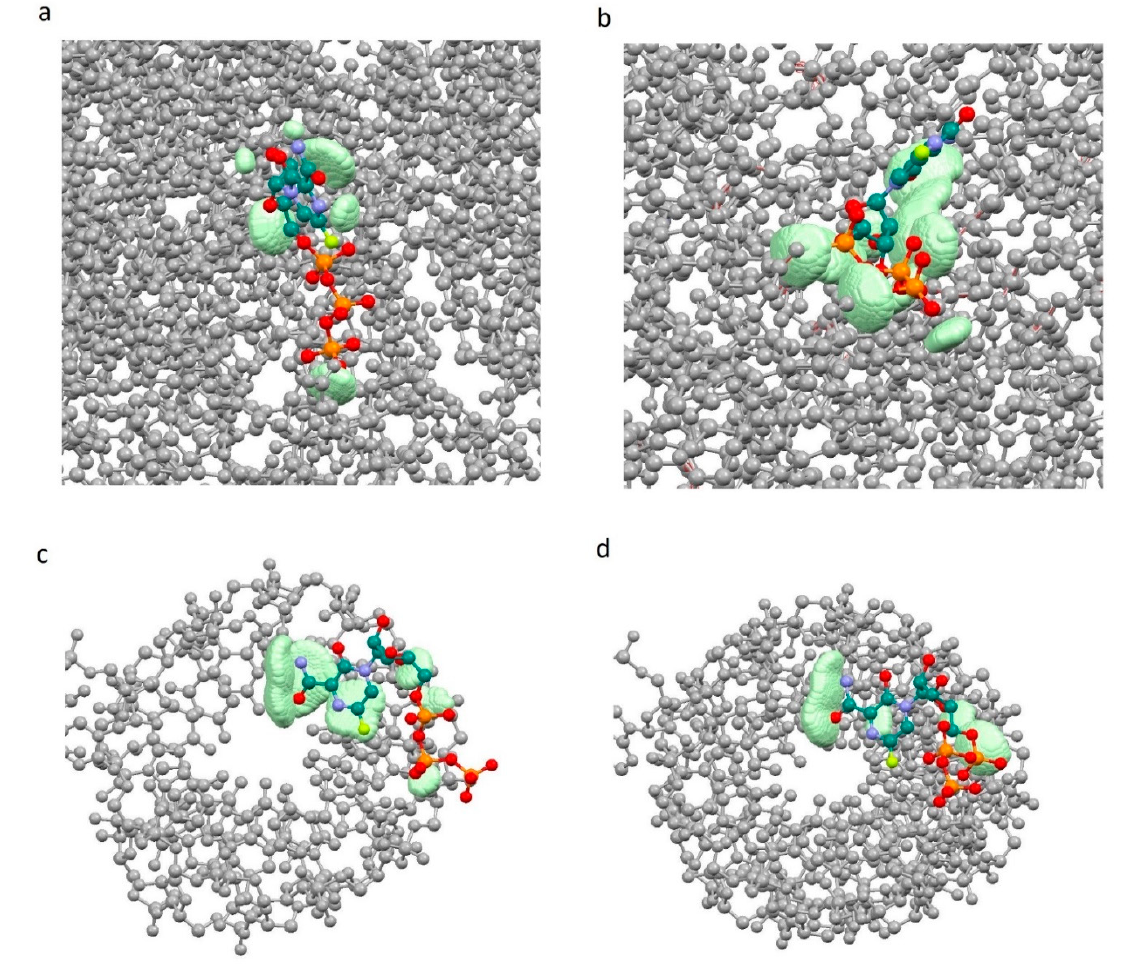
Figure 6. Complementary field of complexes 7CTT and 7AAP: 7AAP enzyme—favipiravir-RTP ( a ), 7CTT enzyme— favipiravir-RTP ( b ), 7AAP RNA—favipiravir-RTP ( c ), 7CTT RNA—favipiravir-RTP ( d ) (grey—enzyme ( a , b ) and RNA ( c , d ), light green—complementary field).